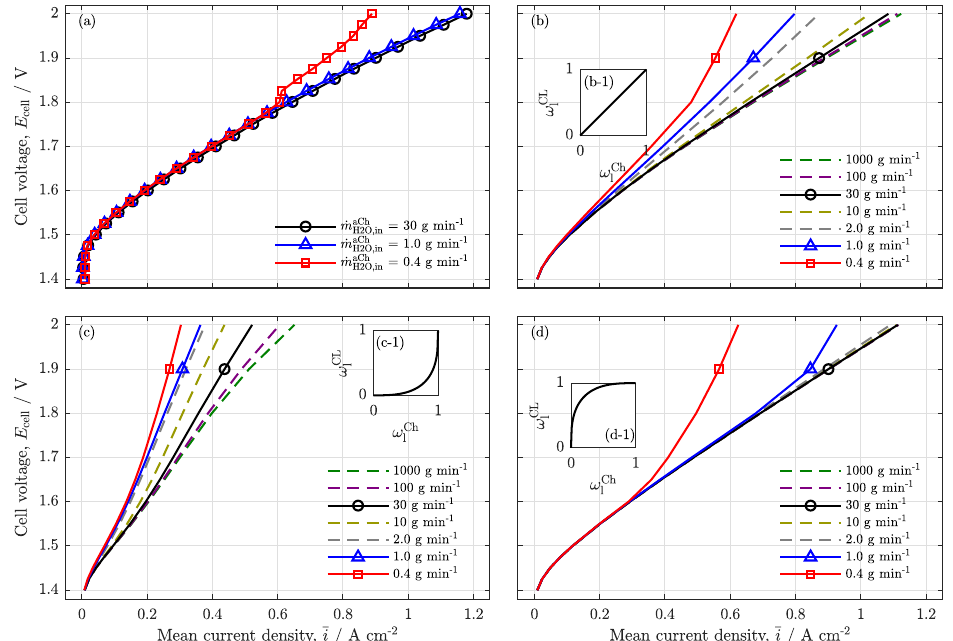
Figure 4. Polarization curves of ( a ) the experimental study (data from Immerz et al. [5], brief description of the experimental setup in Appendix C) with anode inlet water flow rates of 30gmin − 1 , 1.0gmin − 1 and 0.4gmin − 1 and ( b – d ) the model results for those flow rates as full lines with markers with different coupling functions (e.g., Equations (40)); (colored, dashed lines as additional flow rates). ( b ) linear coupling of liquid phase ratios (s. inset (b-1)), ( c ) left-bent coupling (s. inset (c-1)) and ( d ) a right-bent coupling (s. inset (d-1)) for q = 3; temperature T = 60°C, ambient cell pressure p aCh = p cCh =